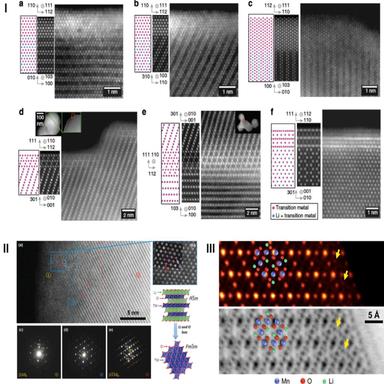
.1. Aberration-corrected HAADF and ABF imaging at surfaces of Li-battery materials. I) (a-f) Experimental and simulated HAADF images of lithium- and nickel-rich Li1.2(Ni0.13Mn0.54Co0.13)O2. for several zone axes, highlighting the spinel structure of the surface layer and the monoclinic structure of the bulk. The interface is (010)M. Adapted from. II) Structural evolution of LixNi1/3Mn1/3Co1/3O2 after 50 cycles. (a, b) Atomic-resolution HAADF-STEM, with the corresponding simulated HAADF image i